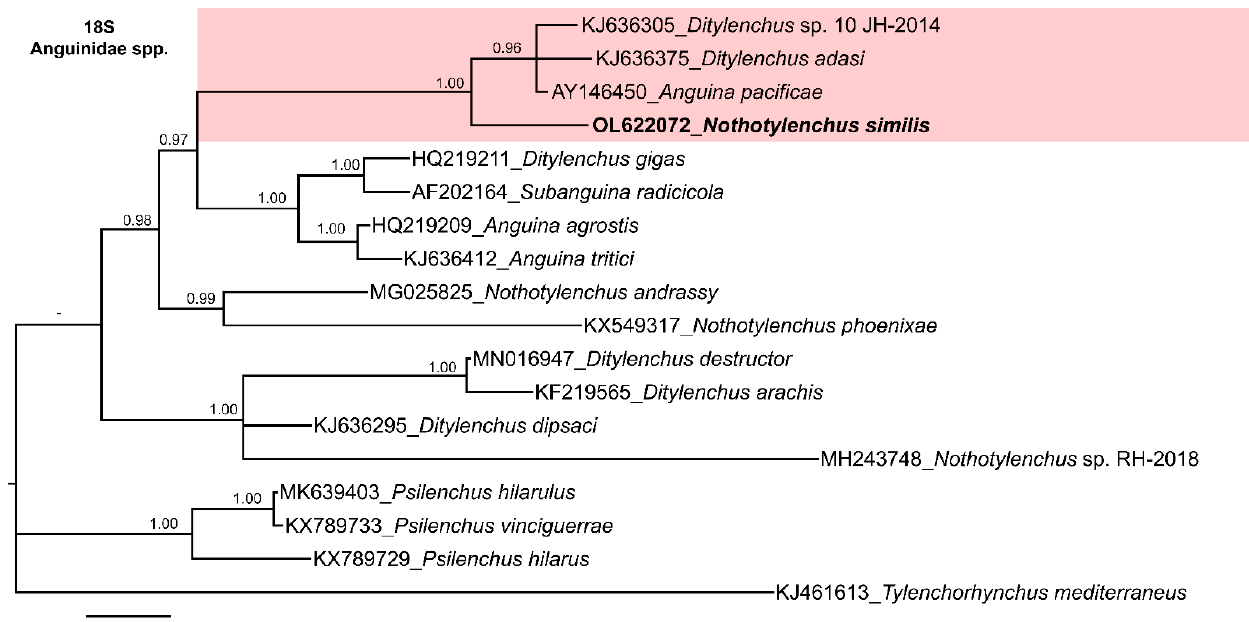
Figure 3. Phylogenetic relationships of Nothotylenchus similis within Anguinidae. Bayesian 50% majority rule consensus tree as inferred from 18S rRNA sequence alignment under the general time-reversible model with invariable sites and a gamma-shaped distribution (GTR + G). Posterior probabilities of more than 0.70 are given for appropriate clades. The sequences produced in this study are shown in bold, and the colored box indicates the clade association of N. similis .